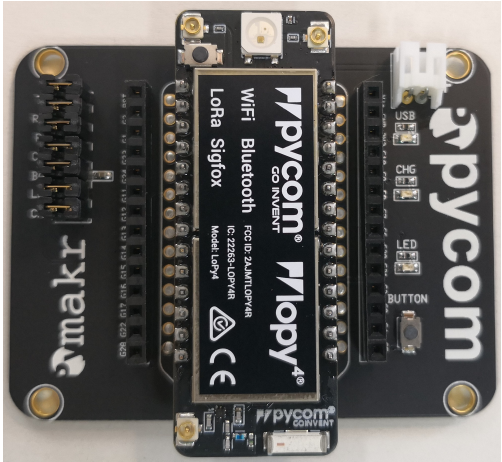
Figure 8. Adopted embedded system for signal processing and measurement data